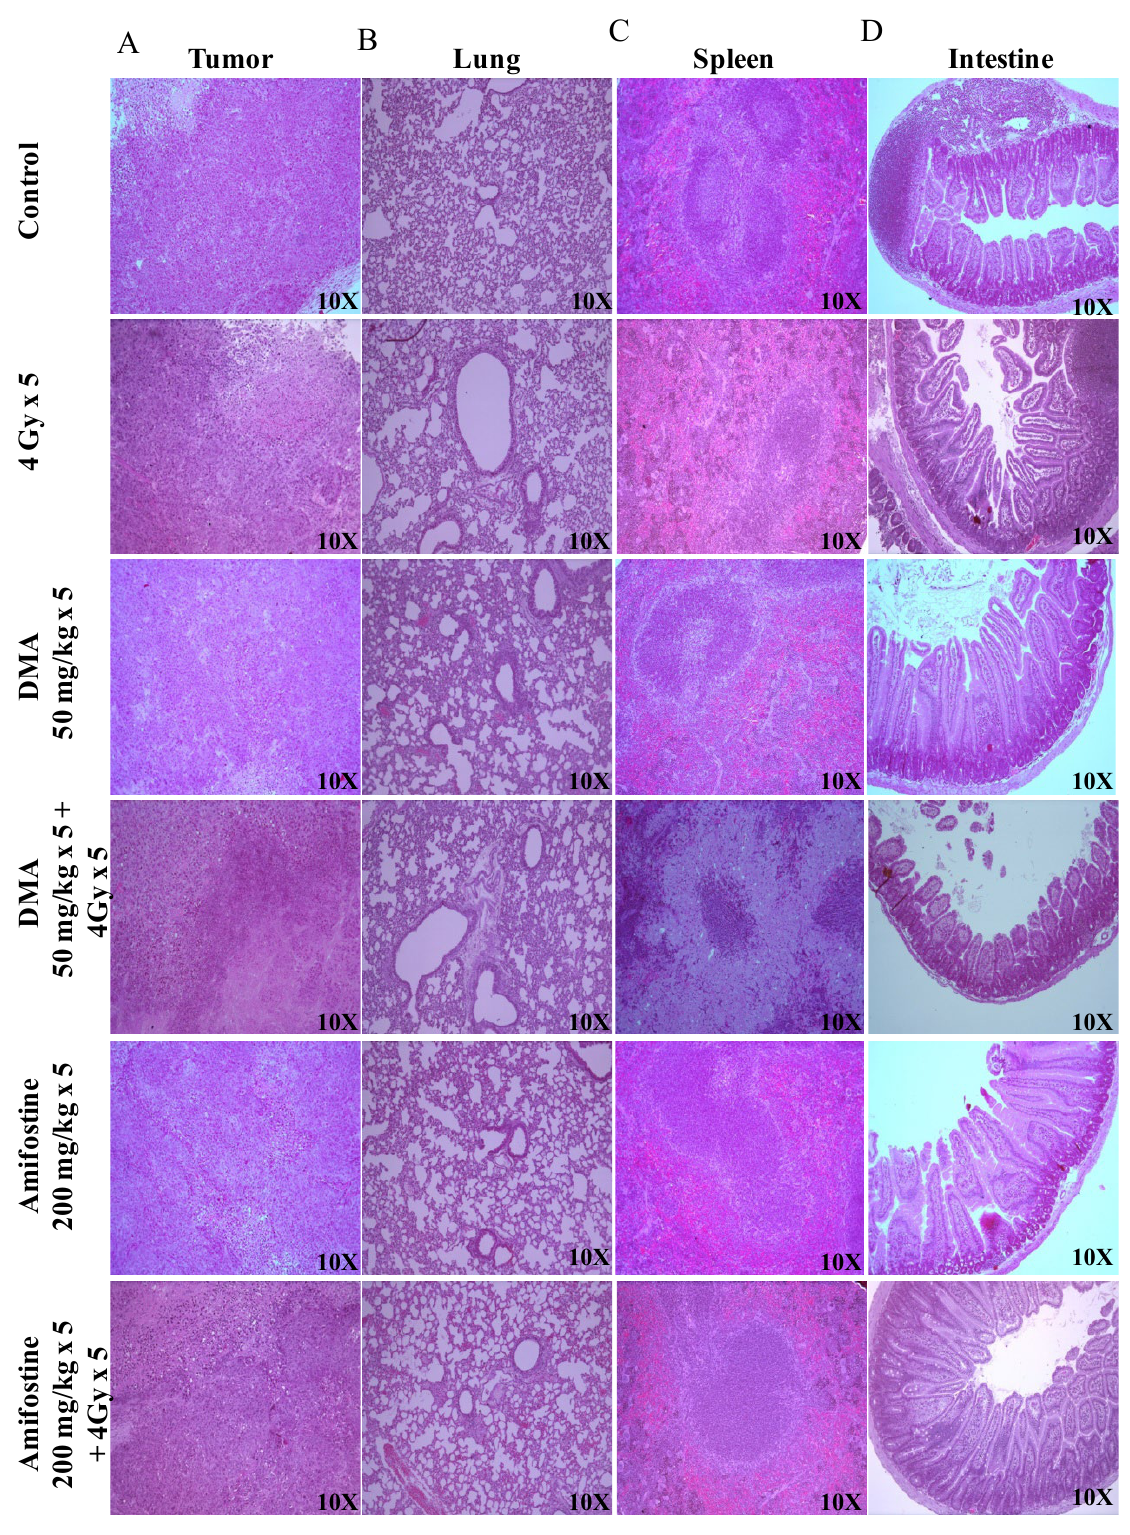
Figure 4. DMA ameliorates radiation-induced damage in normal tissues compared to tumor tissue in HK-1 xenograft. Histological analysis of radiation injury via H&E staining of ( A ) tumor, ( B ) lungs, ( C ) spleen, and ( D ) intestine with and without DMA treatment (50 mg/kg i.v. ) at a magnification of 100×. Images are representative of three tissue samples and three areas per slide. The H&E scoring of the histological analysis of normal tissue is tabulated in Supplementary Table